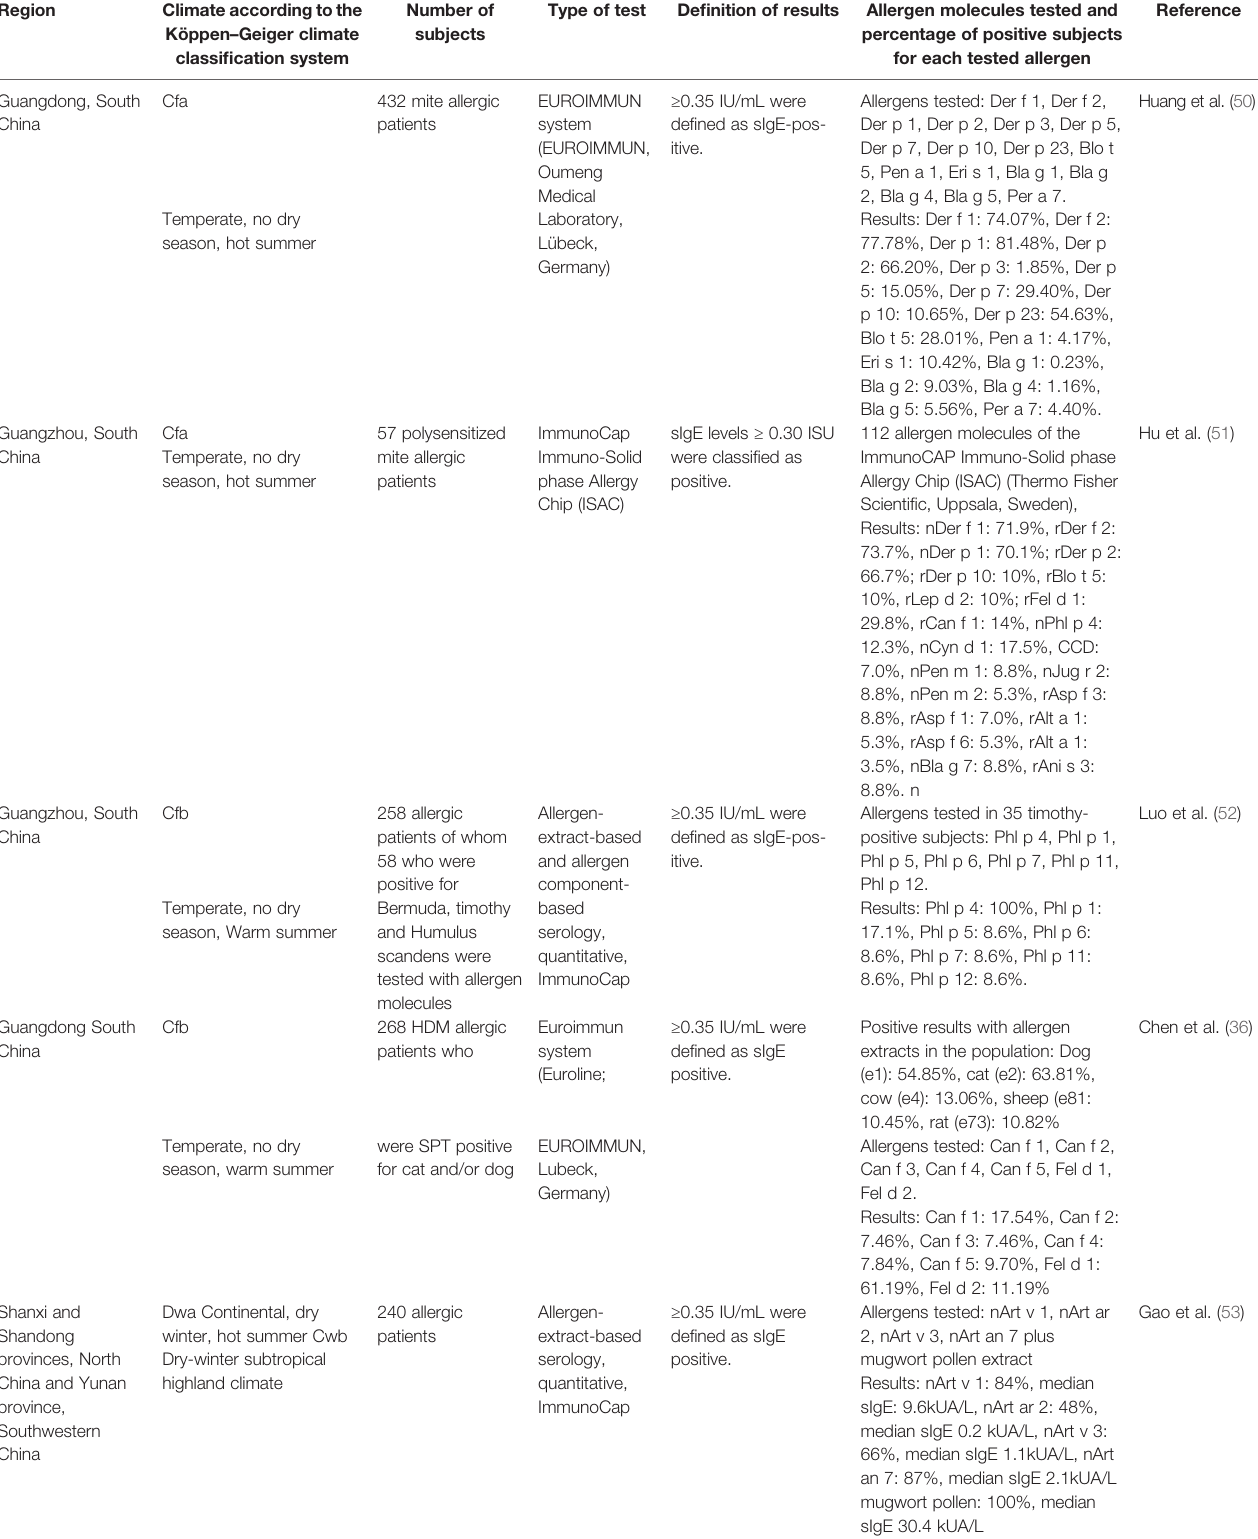
TABLE 3 | IgE sensitization to allergen molecules determined in different regions of China by IgE serology.